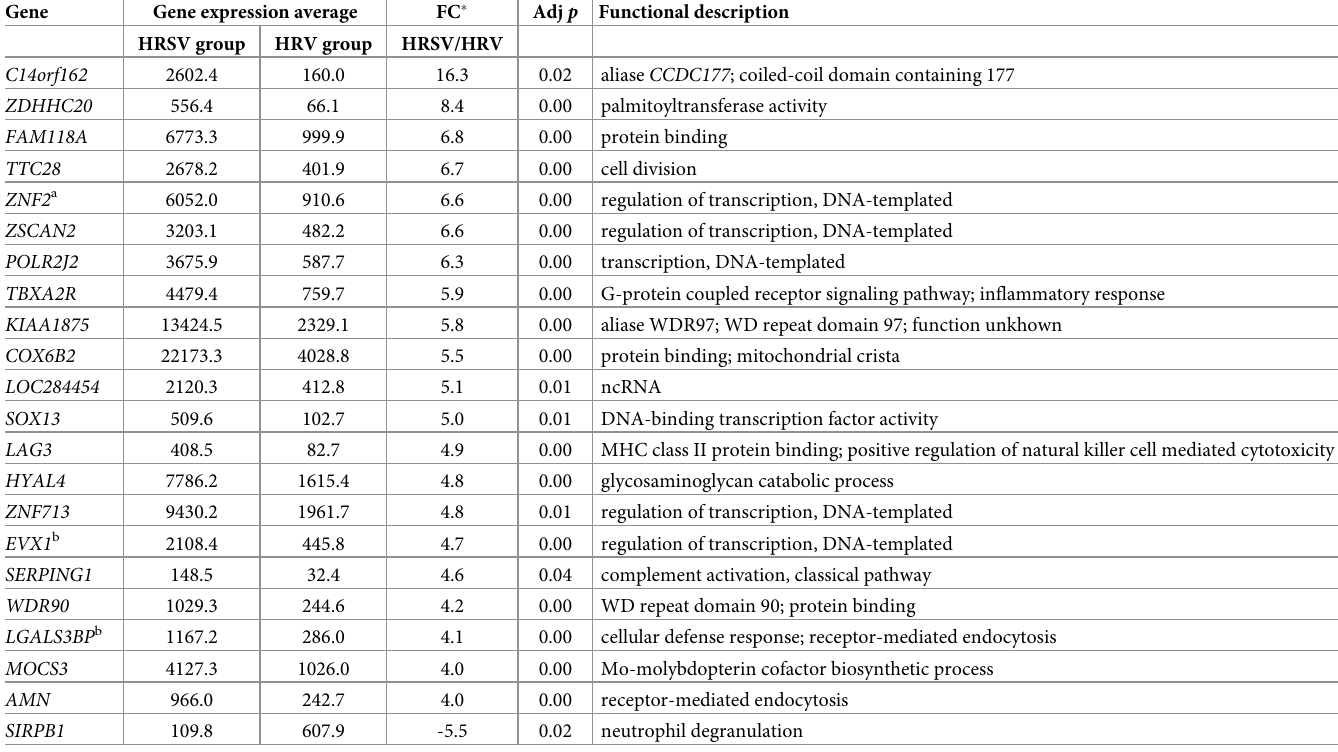
Table 2. Differentially expressed genes with high fold-change ( > 4.0) for HRSV group in comparison with HRV group. Gene Gene expression average FC � Adj p Functional